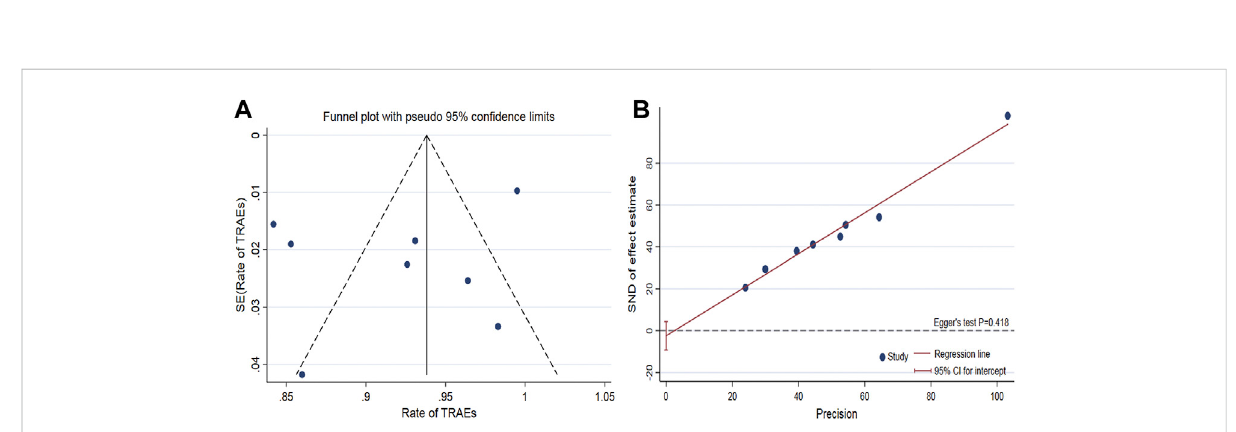
FIGURE 6 Funnel plot to assess publication bias of the pooled TRAEs (A) . Egger ’ s test to measure the funnel plot asymmetry of the pooled TRAEs (B) .